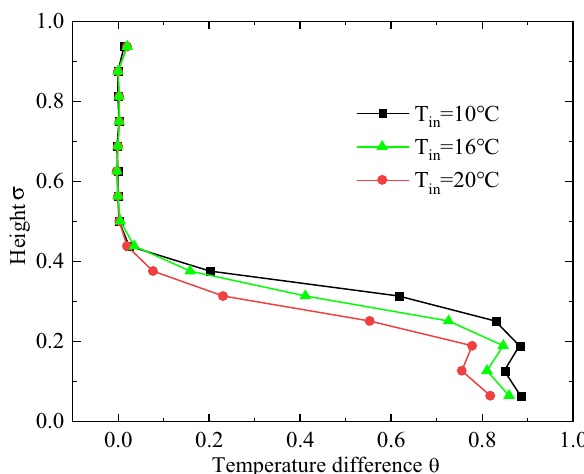
Fig. 14 Temperature change of L1 at different inlet temperatures when Re is 1975 and Fo is 0.9 in forward mode